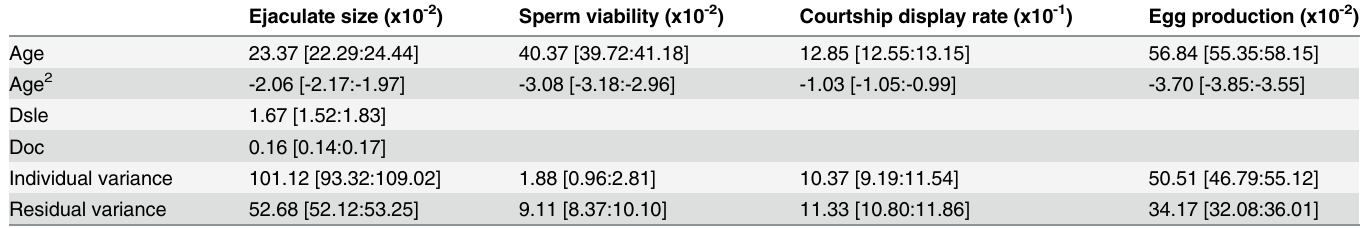
Table 2. Phenotypic senescence for breeding traits of the houbara bustard as evaluated through Age and Age² effects. The date since the last ejac- ulation (Dsle) and the date of collect (Doc) were only fitted for ejaculate size. The values correspond to the posterior mode ± Credible Interval. Ejaculate size (x10 -2 ) Sperm viability (x10 -2 ) Courtship display rate (x10 -1 ) Egg production (x10 -2